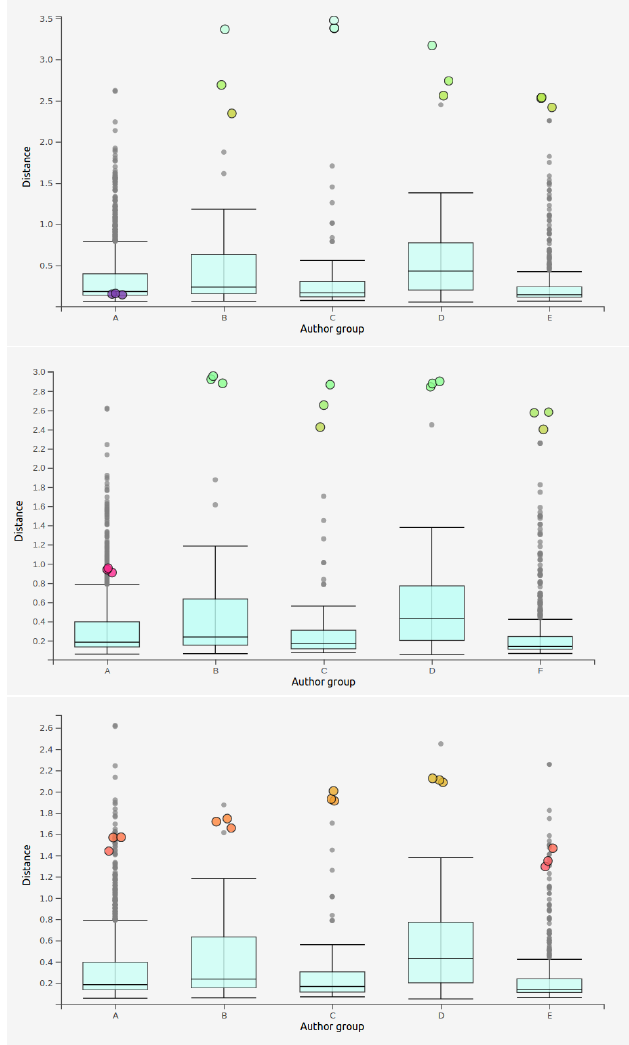
Figure 1. Three examples of data visualization. for human